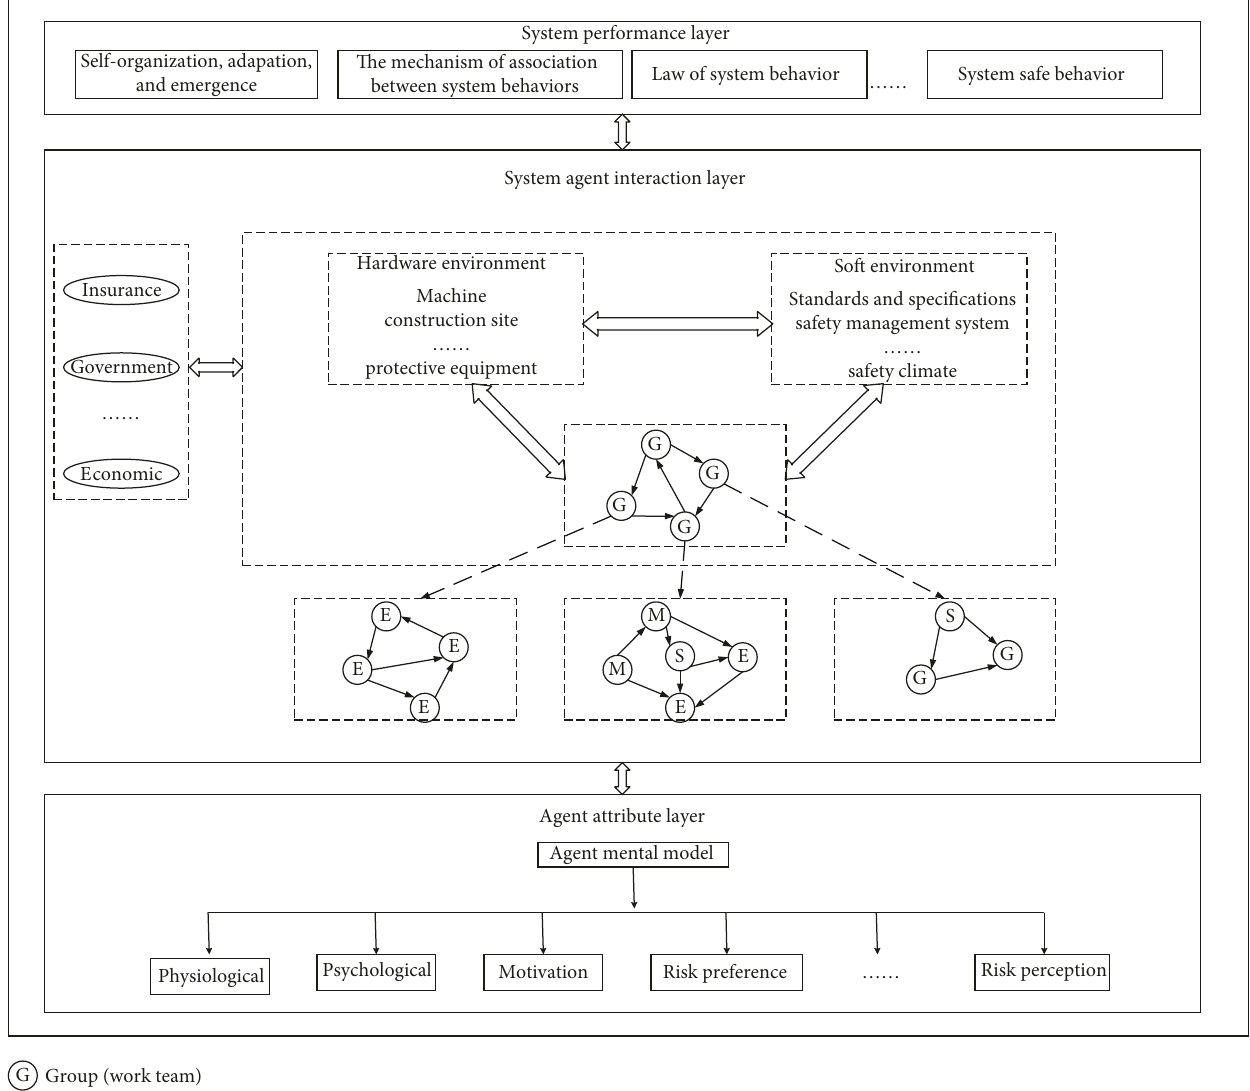
Figure 2: Three-layer structural model framework for studying unsafe behavior in construction